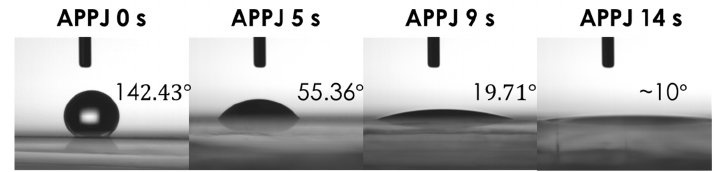
Figure 5. Water contact angles of samples (100 µ L H 2 PtCl 6 solution added) sintered by APPJ for various times.